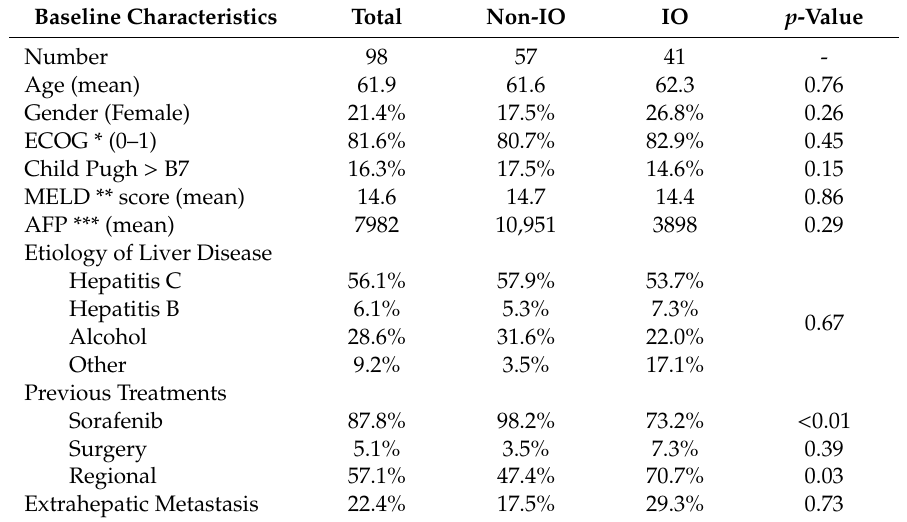
Table 2. Baseline Characteristics (comparing patients who received second-line non-IO versus IO).